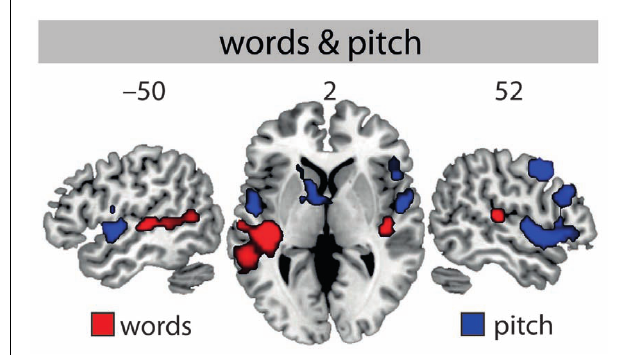
FIGURE 4 | Comparison of word and pitch processing in vocal stimuli. Words-pitch (red) [(wpr–pr)–(pr–r)], pitch-words (blue) [(pr–r)–(wpr–pr)][ p (cluster-size corrected) < 0.05 in combination with p (uncorrected) <